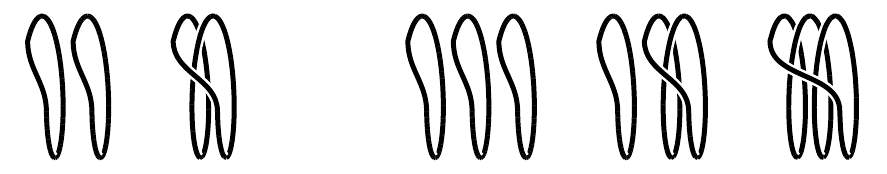
Figure 5 . The S N -bundles in the toy model for N = 2 and N = 3